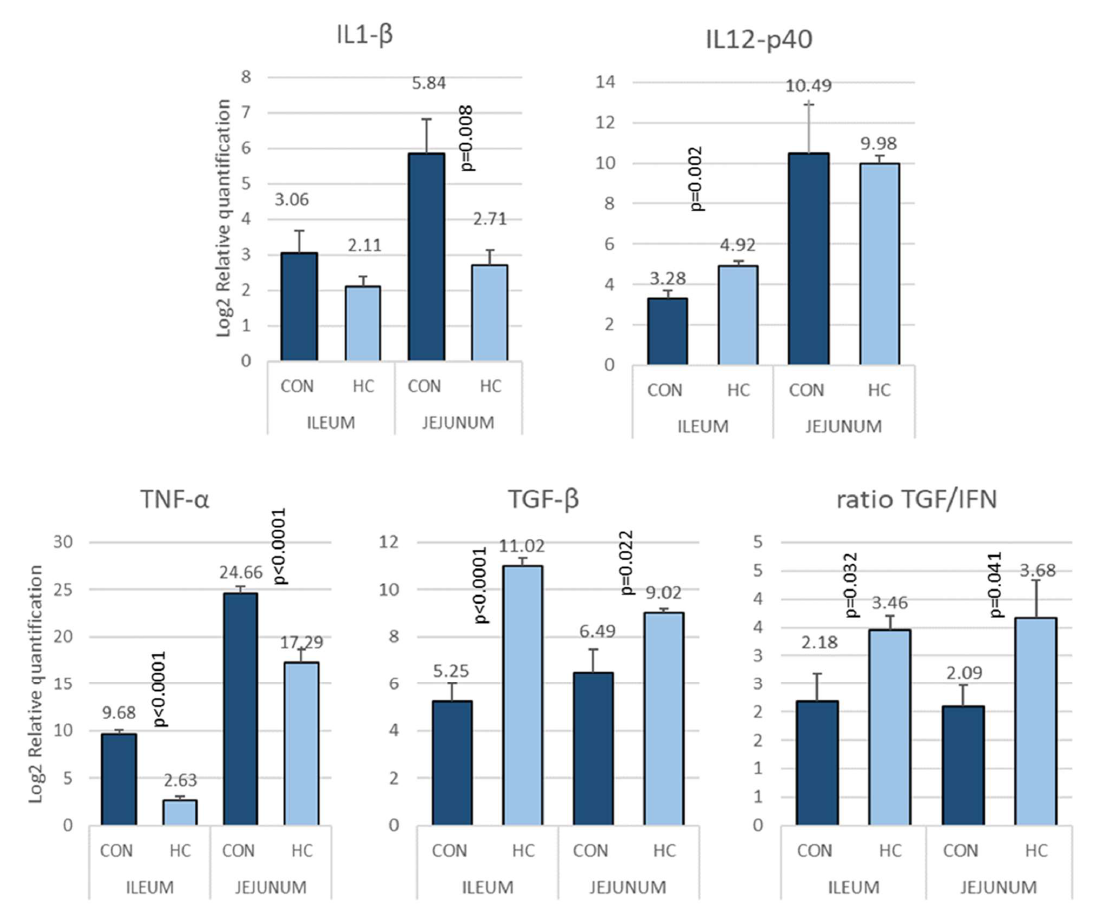
Figure 6. Biomarkers showing differences between CON and HC, expressed as Log2 of relative quantitation on tissue samples at slaughter. The results are expressed as Log2 of fold change, normalizing against the lower value which was assigned as 1. The bars represent Mean ± SEM. The frequency of each gastric observed lesion is showed in Figure 7. No crateriform or healed ulcers were observed, and the frequency for ulcers was lower than previously observed for other fattening pigs. There were no significant differences between the observed and expected frequencies for any of the observed lesional categories when comparing the two experimental groups.